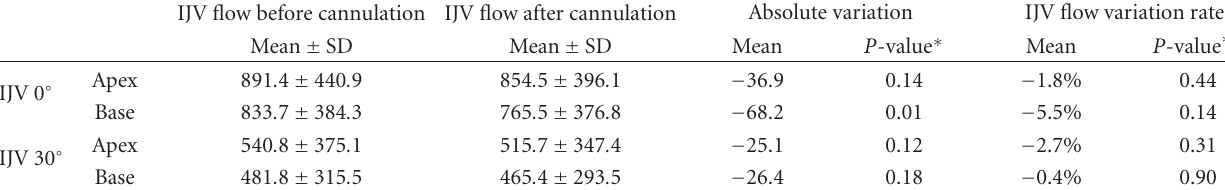
Table 3: Flows analysis